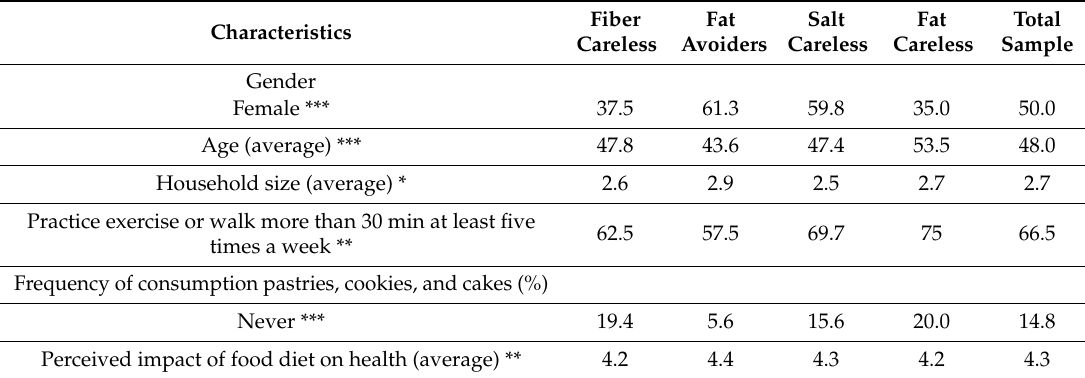
Table 9. Pastries: Profiling consumer segments (%, unless